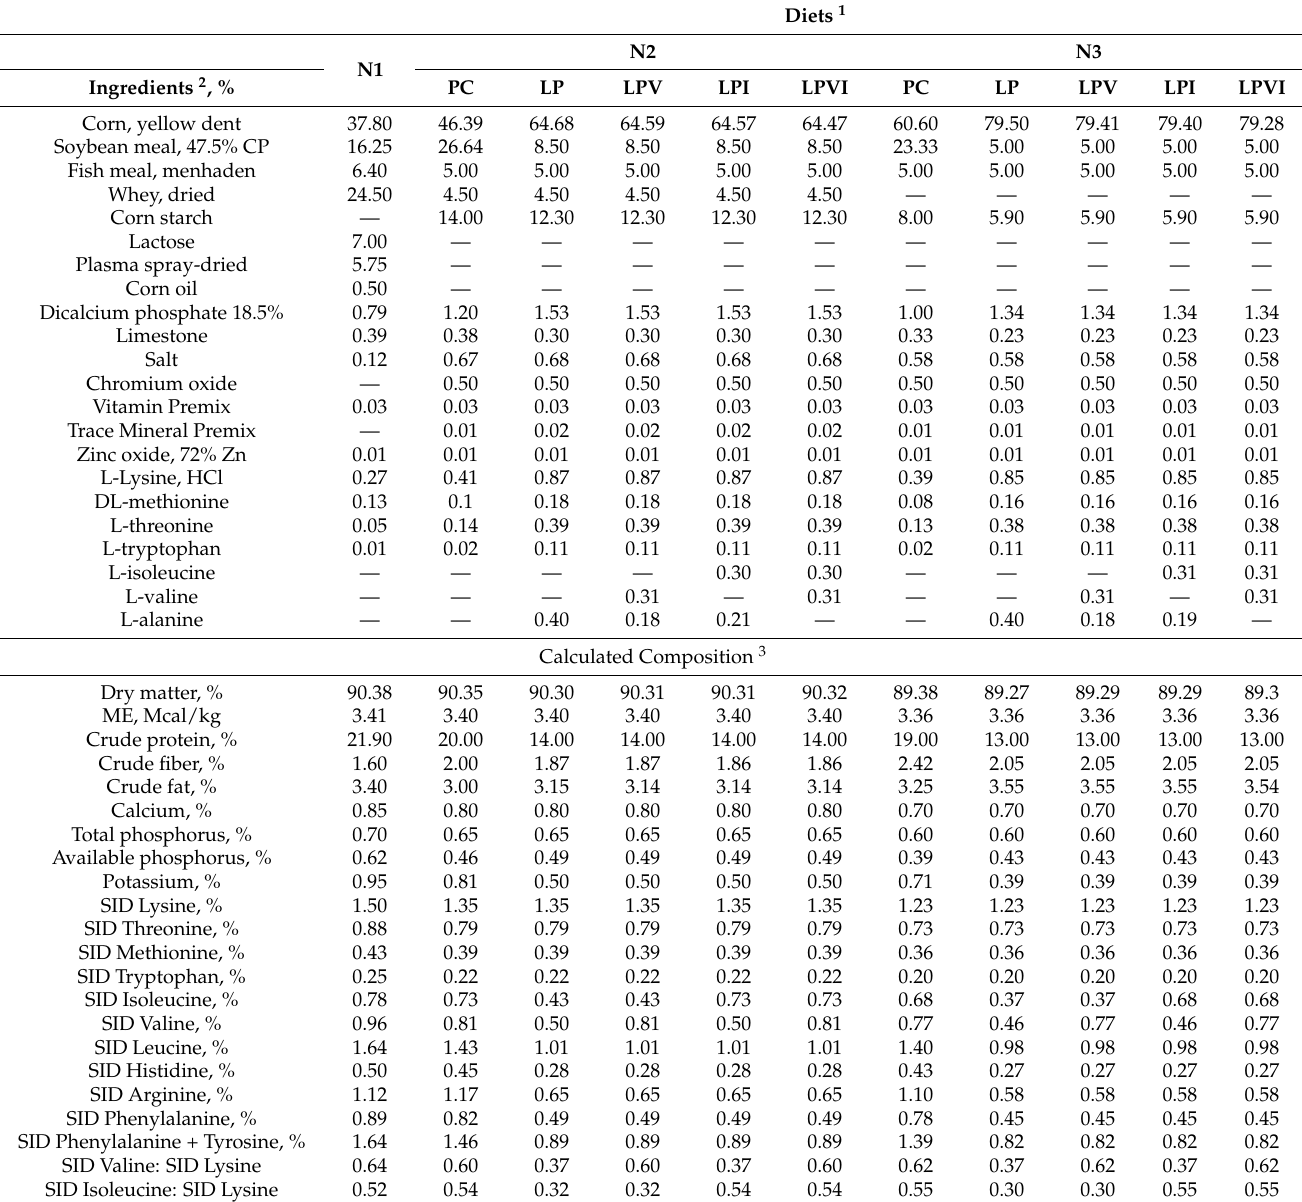
Table 4. Ingredients and calculated chemical composition of experimental diets (as-fed